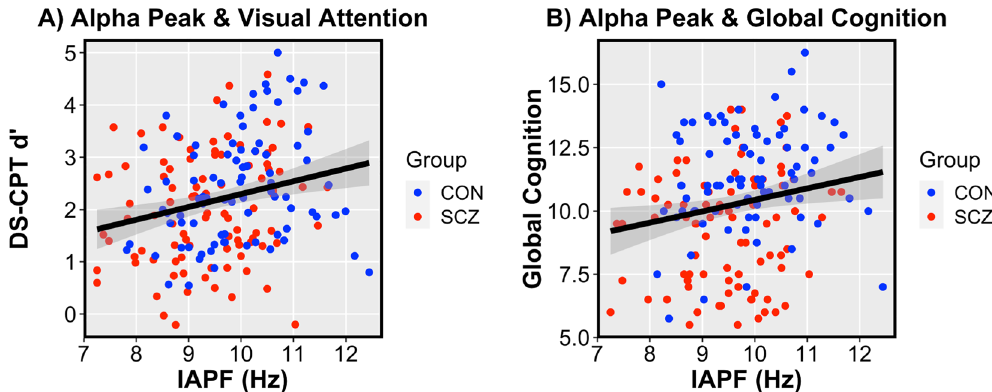
Figure 2. Mean IAPF was predictive of d ′ on the DS-CPT and global cognition across both the CON and SCZ groups. ( A ) Mean IAPF predicted discrimination (d ′ ) between targets and non-targets on a visual attention task (DS-CPT) across groups ( t = 3.48; p = 0.0006). ( B ) Mean IAPF predicted global cognition measured on the WAIS-III across groups ( t = 3.04; p = 0.003).